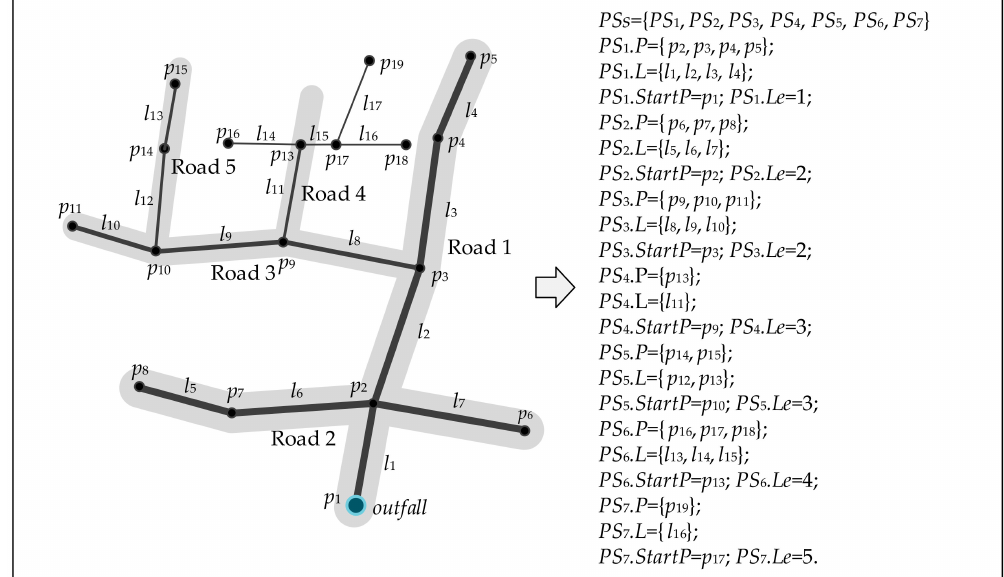
Figure 4. Example of pipe stroke construction. The plot on the left side of the arrow is the original sewer network, and the right side shows the corresponding pipe strokes.